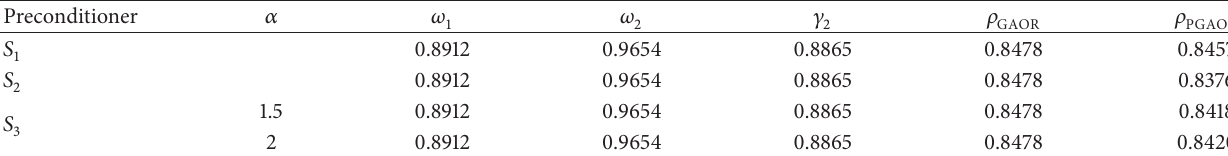
Table 1: Spectral radii of GAOR method and PGAOR method.